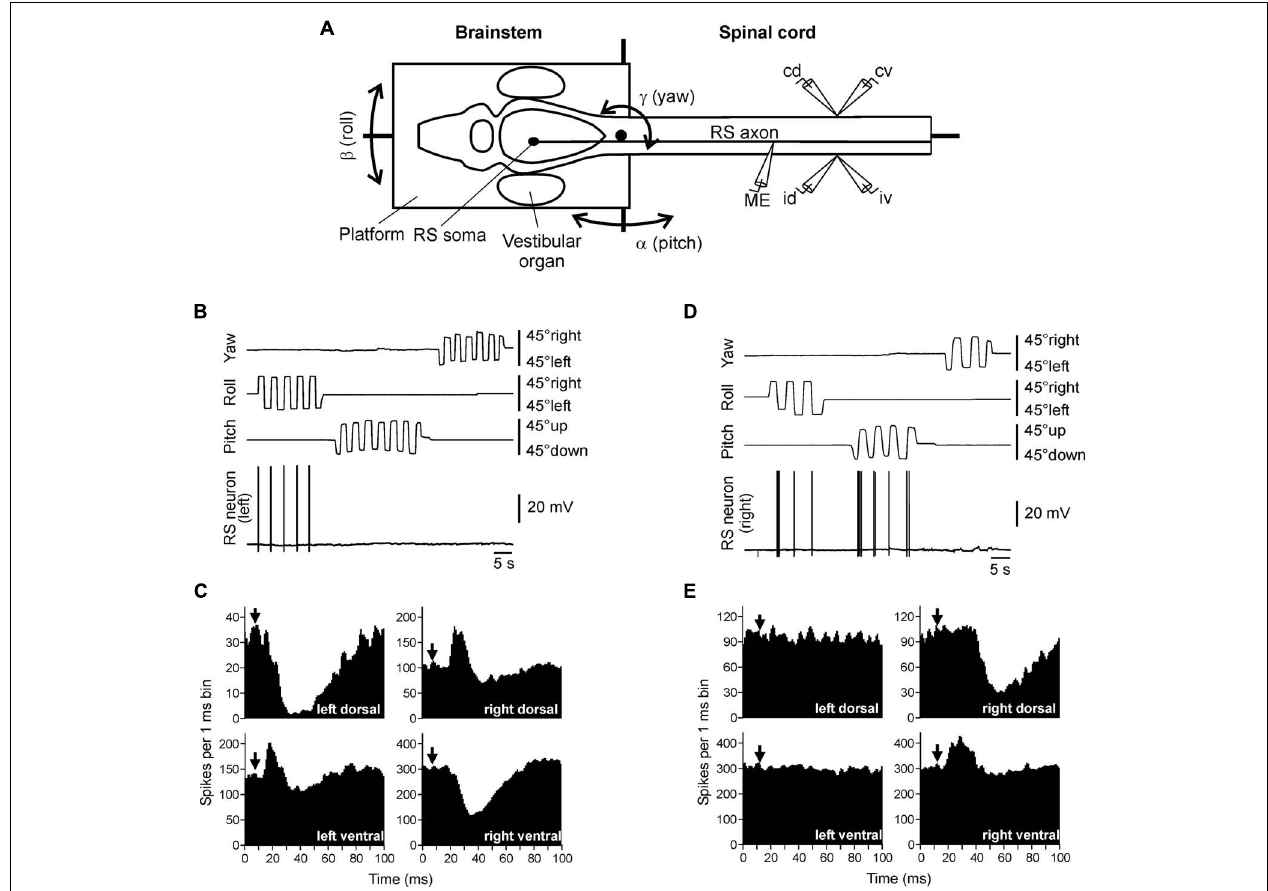
FIGURE 3 | Vestibular inputs and motor outputs of individual RS neurons. (A) The brainstem – spinal cord preparation with vestibular organs was used for studying vestibular inputs to individual RS neurons and their motor effects. The preparation was positioned in a chamber and perfused with Ringer solution. The brainstem with vestibular organs could be rotated around three axes: transverse (pitch), longitudinal (roll), and vertical (yaw). D -glutamate was applied to the spinal cord to elicit fictive locomotion. Individual neurons were recorded from their axons in the spinal cord. To stimulate a neuron, positive current pulses were passed through the recording intracellular microelectrode (ME). Activity of MNs was recorded bilaterally in the segment 30 by suction electrodes, from the dorsal and ventral branches of a ventral root ( id , ipsilateral dorsal branch; iv , ipsilateral ventral; cd , contralateral dorsal; cv , contralateral ventral). (B,C) An RS neuron that contributed only to stabilization of the body orientation in the transverse plane. The neuron fired spikes in